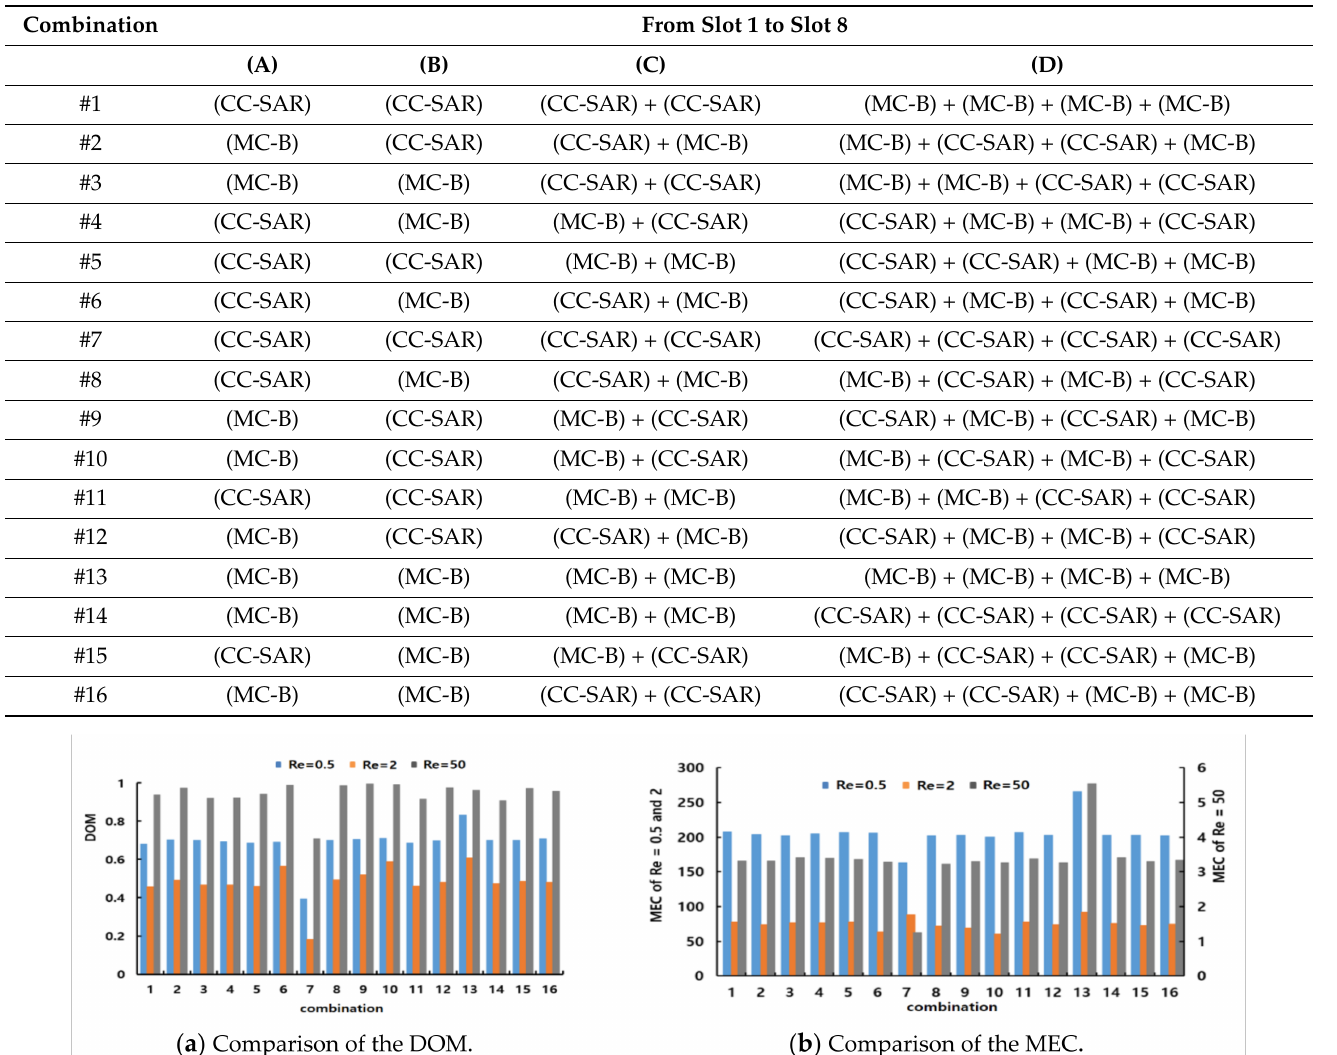
Table 3. Full factorial combination for eight slots.